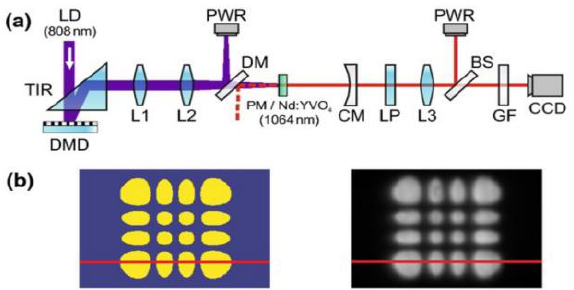
Figure 6. ( a ) Schematic of the vector pump-shaping laser; ( b ) Pump patterns of the HG 3,3 mode and corresponding CCD image (Adapted from an open-access source Ref. [73]).